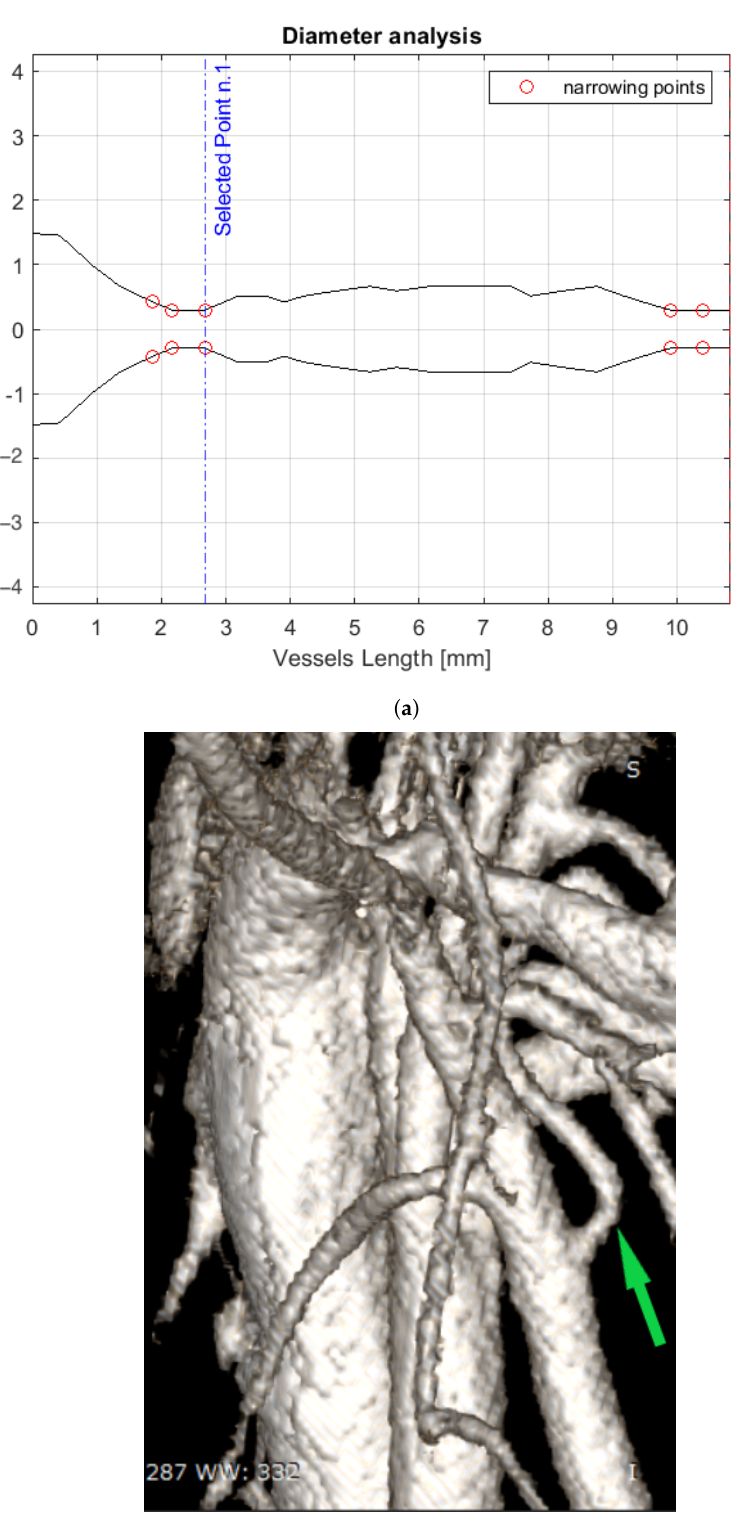
Figure 8. ( a ) Linear representation of a vessel presenting five narrowing points that are highlighted with red circles. ( b ) A view of the 3D image of the vascular tree. The green arrow indicates the analyzed vessel in ( a